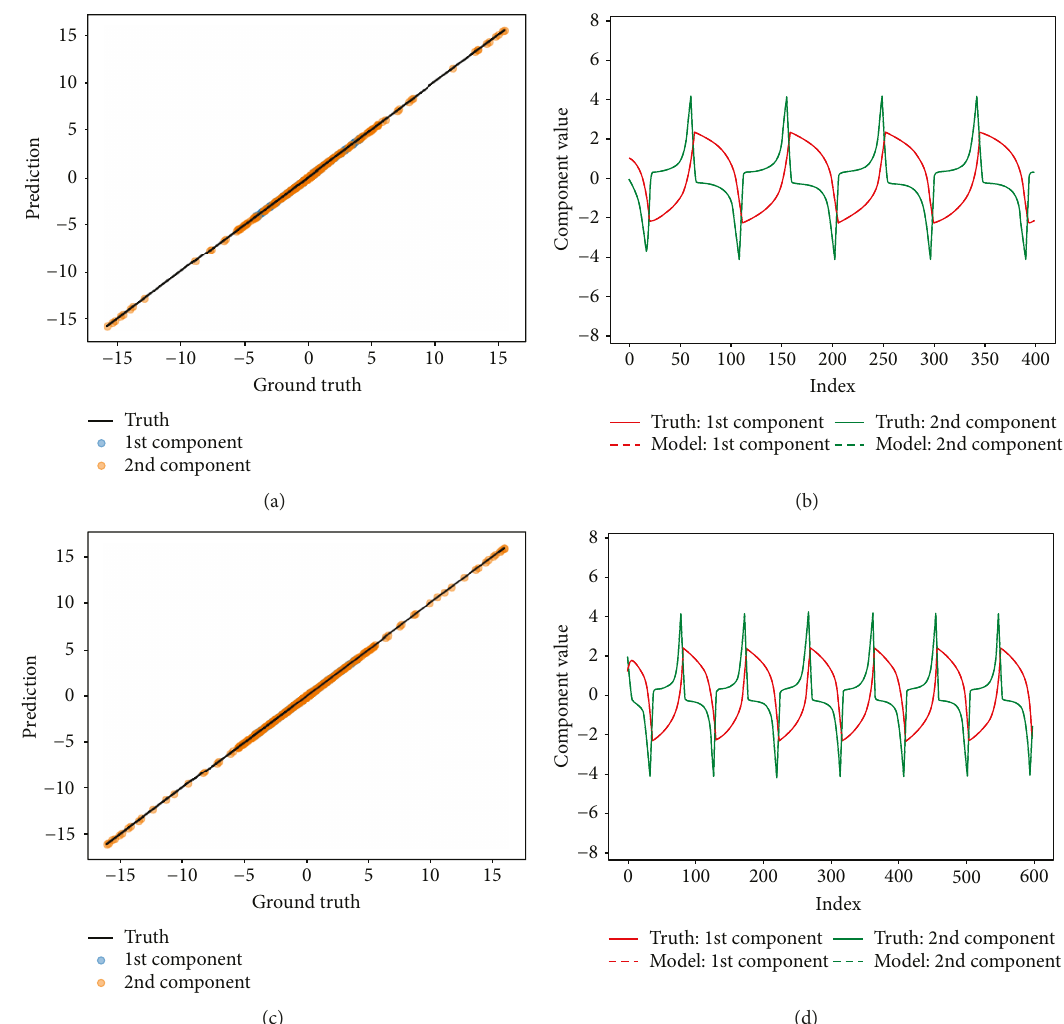
Figure 5: A priori and a posteriori result of SINDy on VDP case. (a, b) Training data. (c, d) Testing data. (a, c) A priori. (b, d) A